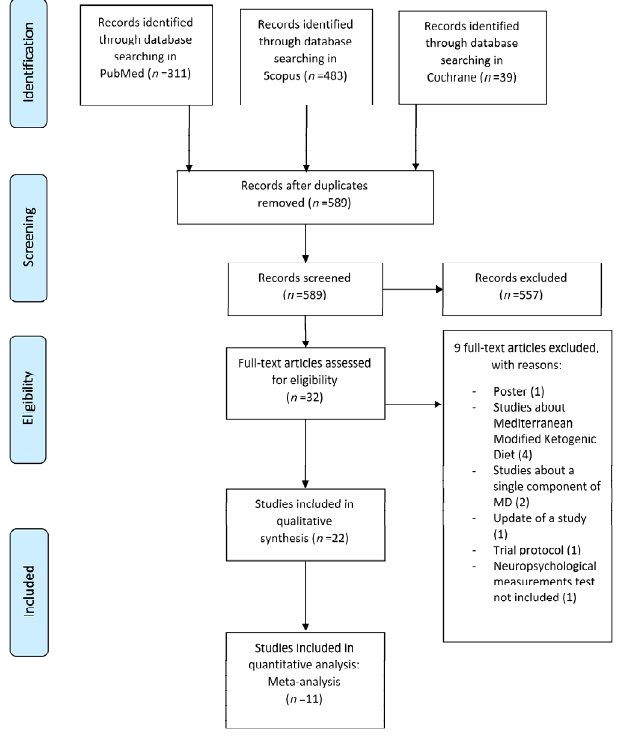
Figure 1. Flowchart of identification and selection of